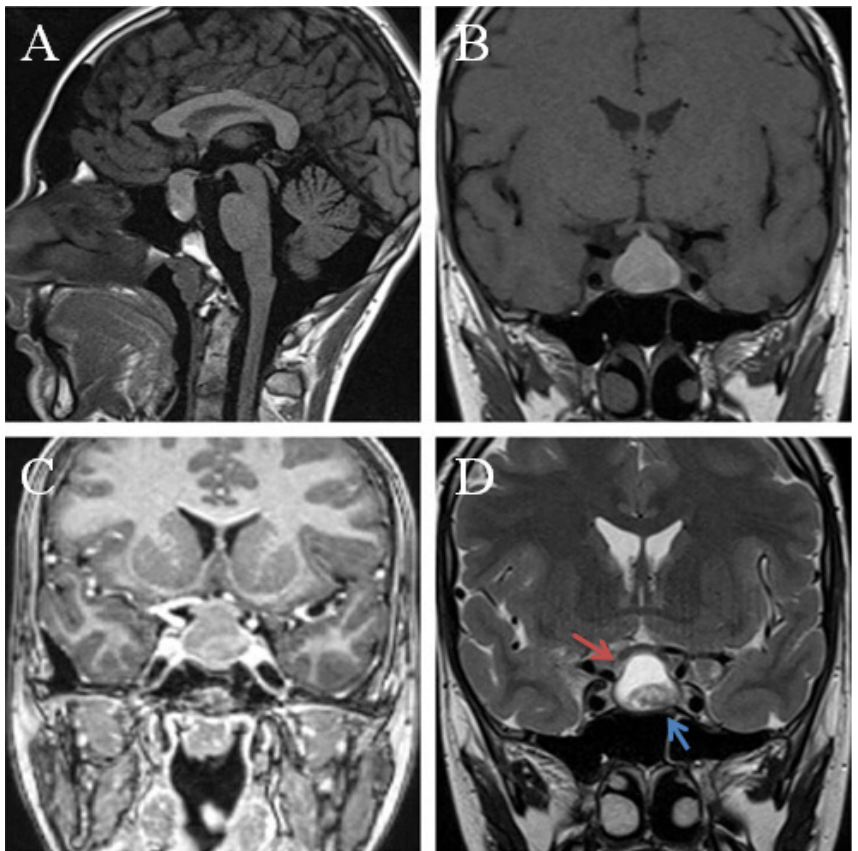
Figure 3. Preoperative MRI of a sellar lesion measuring 25 mm, and postoperatively diagnosed as xanthogranuloma of the sellar region. Sagital pre-contrast T1WI ( A ) demonstrates an isointense signal. The lesion was isointense on T1 precontrast sequences ( B ) with a corresponding mixed signal on T2 sequences ( D ) cystic component hyperintense (red arrow) and a hypointense solid component (blue arrow). Coronal postcontrast T1 ( C ) shows peripheral contrast enhancement. The tumor compressed the pituitary gland and the optic chiasma